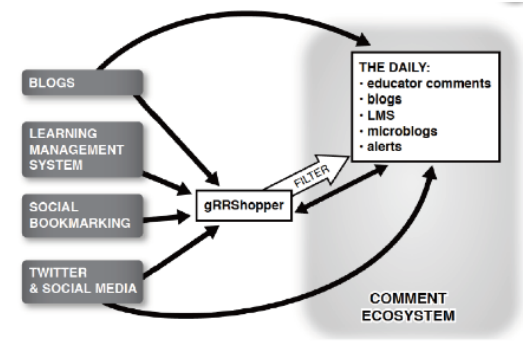
Figure 1. Structure of daily